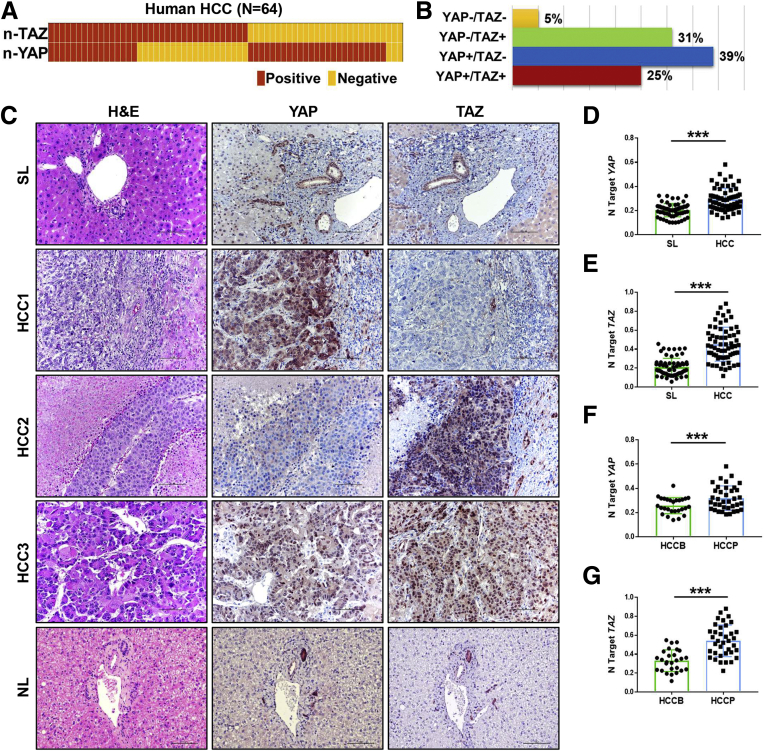
YAP and TAZ expression in human HCC samples. (A) Heatmap of nuclear TAZ and YAP staining patterns among HCC samples (N = 64). (B) Percentage of 4 different nuclear YAP and TAZ staining patterns. (C) Representative images of IHC staining against YAP and TAZ in human normal liver (NL), nontumorous surrounding tumor tissues (SL), and HCC. Original magnification: 200×. Scale bar: 100 μm. (D and E) Real-time qPCR analysis of YAP and TAZ mRNA levels in HCC (N = 64) and corresponding nontumorous surrounding liver tissues (SL) (N = 64). (F and G) Real-time qPCR analysis of YAP and TAZ mRNA levels in HCC with a better prognosis (HCCB) (n = 27) and HCC with a poorer prognosis (HCCP) (n = 37). Quantitative values were calculated by using the PE Biosystems Analysis software and expressed as a number target (N Target). N Target = 2−ΔCt, wherein the ΔCt value of each sample was calculated by subtracting the average Ct value of the gene of interest from the average Ct value of the β-actin gene. The P value was calculated using the Student t test: ∗∗∗P < .001 when compared with SL or HCCB.